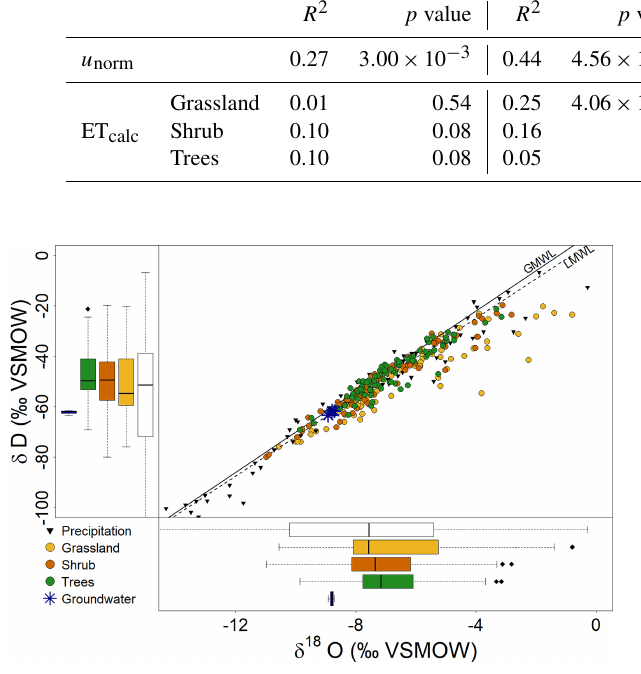
Figure 4. Dual isotope and box plots showing the isotopic composi- tion of incoming P and local groundwater sampled ∼ 2 . 5km north of the SUEO (Kuhlemann et al., 2020a), as well as the isotopic com- position of sampled bulk soil water at different depths between 0 and 90cm under grassland, shrub and tree